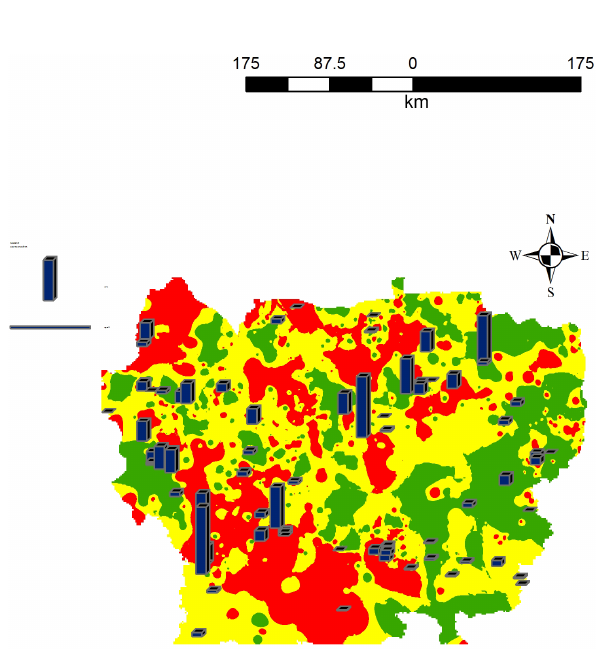
Figure 14. Nitrate distribution in the DRASTIC